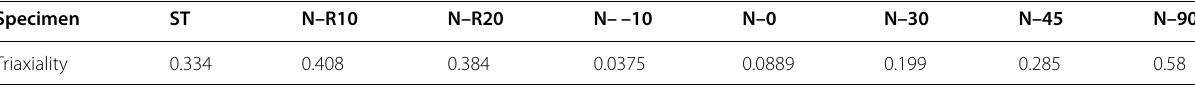
Table 4 Stress triaxiality values of specimens Specimen ST Triaxiality